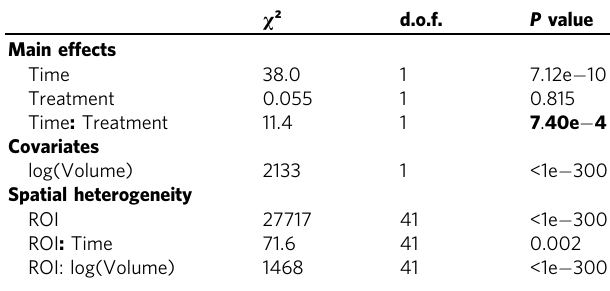
patients achieving a modi fi ed Rankin scale score of 0 or 1 after 3 months (favorable outcome) was not signi fi cantly mediated by lesion growth (natural indirect effect 1.04, CI 95% [0.96, 1.17],